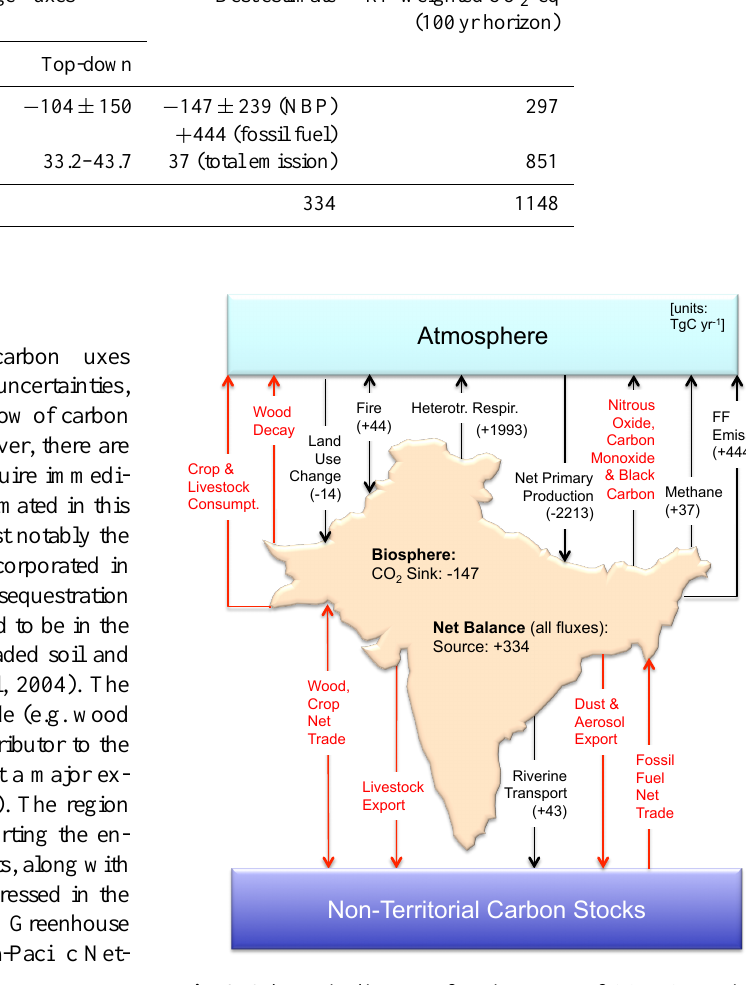
Fig. 6. Schematic diagram of major fluxes of CO 2 , CH 4 nitrous oxide (N 2 O) and related species in the South Asia region. The flux components written in black ink are discussed in this work, and Fig.6. Schematicdiagramofmajorfluxesof CO 2 , CH 4 nitrousoxide( N 2 O )andrelatedspeciesinSouthAsiaregion. Thefluxcomponents those marked in red ink requires attention for further strengthening written in black ink are discussed in this work, and those marked in red ink requires attention for further strengthening our knowledge of of our knowledge in regional GHGs budget. Direction of net carbon flow has not been determined well for some of the fluxes, which are represented by lines with arrowheads on both